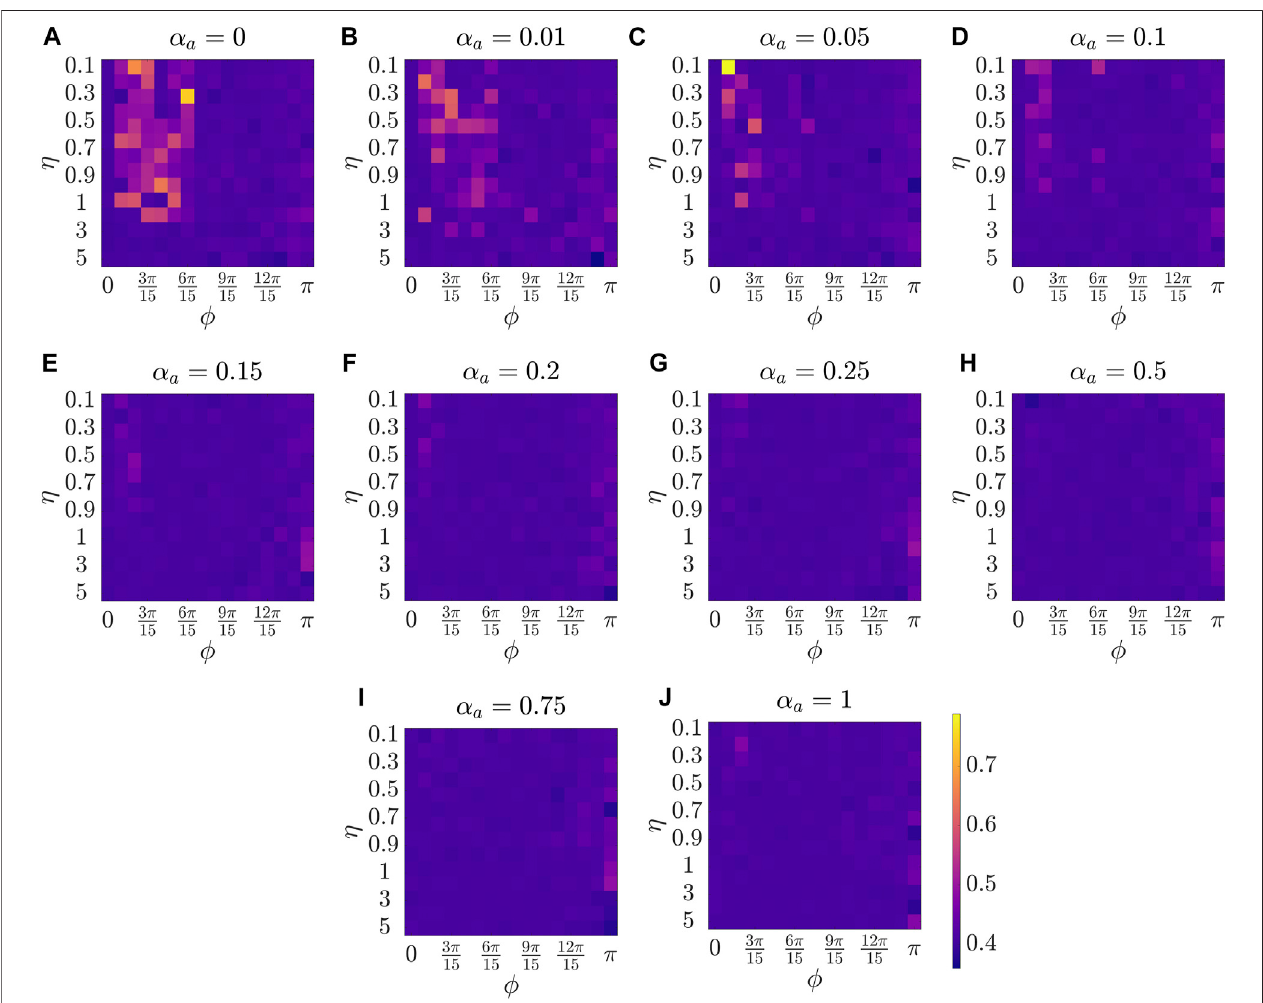
FIGURE 3 | Results for the mean cohesion size at different values of α a , shown at the title of each sub- fi gure. Within each sub- fi gure (A – J) , η is varied along the vertical axis, and ϕ is varied along the horizontal axis.